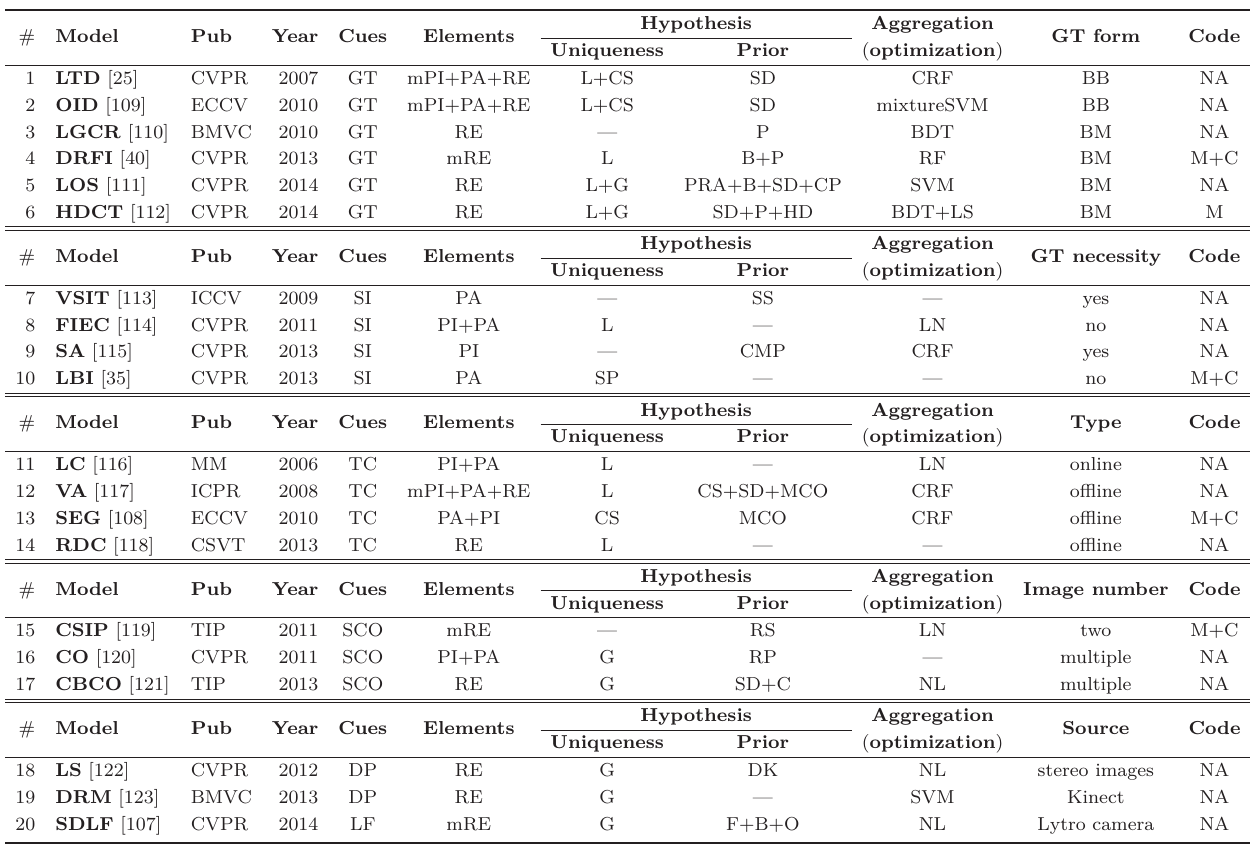
Table 2 Salient object detection models with extrinsic cues grouped by their adopted cues. For cues: { GT = ground-truth annotation, SI = similar images, TC = temporal cues, SCO = saliency co-occurrence, DP = depth, and LF = light field } . For saliency hypothesis: { P = generic properties, PRA = pre-attention cues, HD = discriminativity in high-dimensional feature space, SS = saliency similarity, CMP = complement of saliency cues, SP = sampling probability, MCO = motion coherence, RP = repeatedness, RS = region similarity, C = corresponding, and